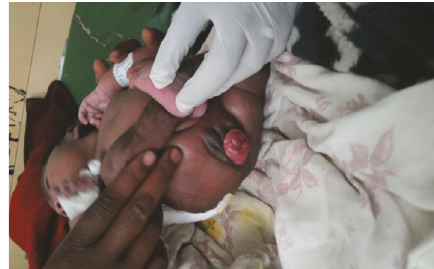
Figure 1: Picture of the uterovaginal prolapse.